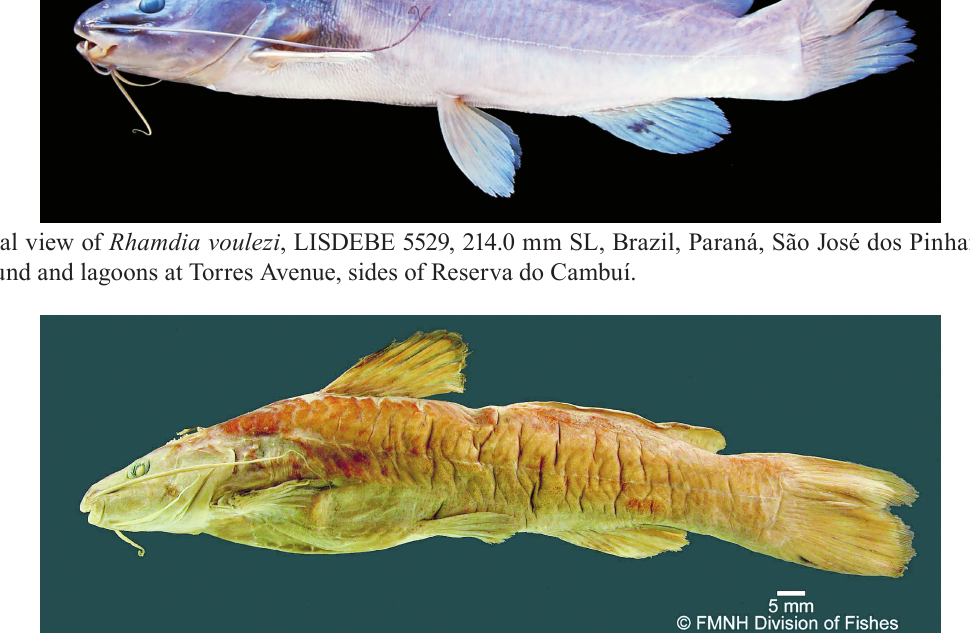
Fig. 7. Lateral view of holotype of Rhamdia branneri voulezi , FMNH 54238, 122.0 mm SL, Brazil, Paraná, Porto União da Vitória, rio